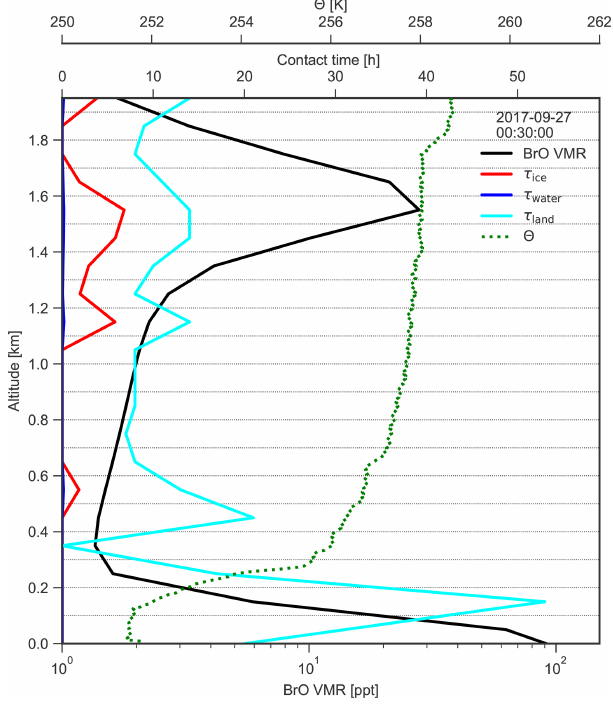
Figure 17. Vertical profile of BrO VMR, as well as contact times with sea ice, land, and water at AH on 27 September 2017 at 00:30UTC, together with the vertical profile of potential tempera- ture (cid:50) inferred from a coincident balloon sonde measurement. The dotted horizontal lines indicate the MAX-DOAS retrieval grid.